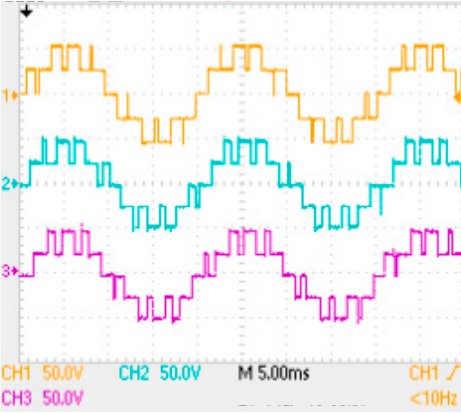
Figure 14. Switch states of PSC-SVPWM. (CH1: port voltage of Module 1; CH2: port voltage of Module 2; CH3: port voltage of Module 3; CH4: whole port voltage ).